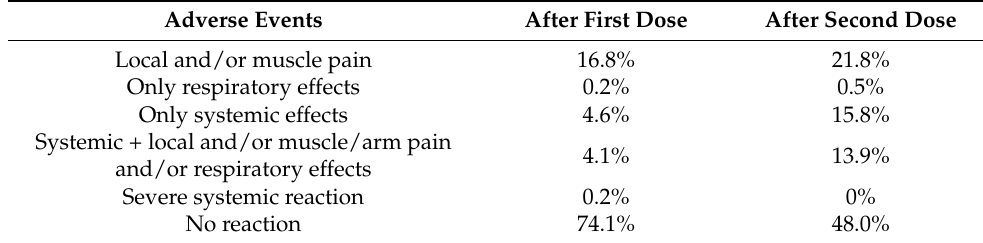
Table 2. Adverse events after first or second dose of vaccine.